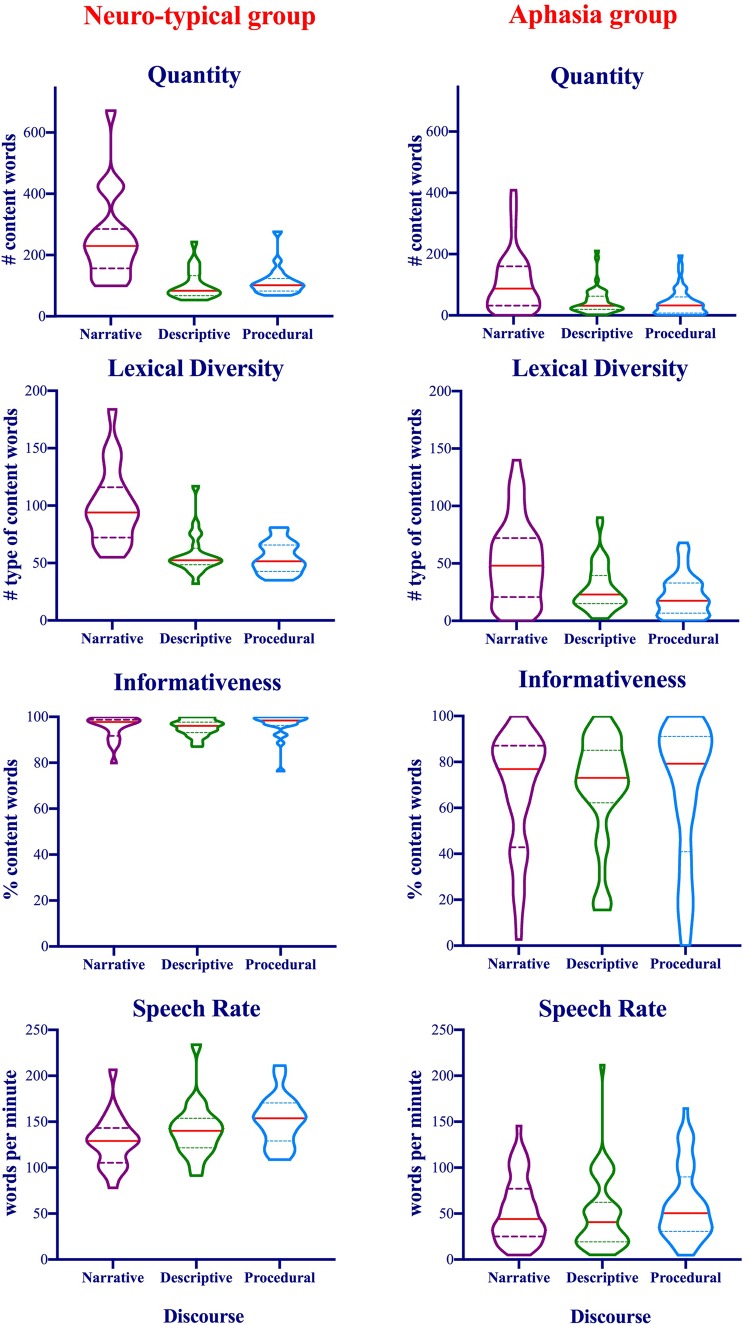

Violin plots showing the distribution of the data and the probability density of four connected speech measures produced during three discourse genres among both neurotypical and patients with aphasia groups. Straight red lines refer to the group median, top dotted lines refer to the third quartile, and bottom dotted lines refer to the first quartile.